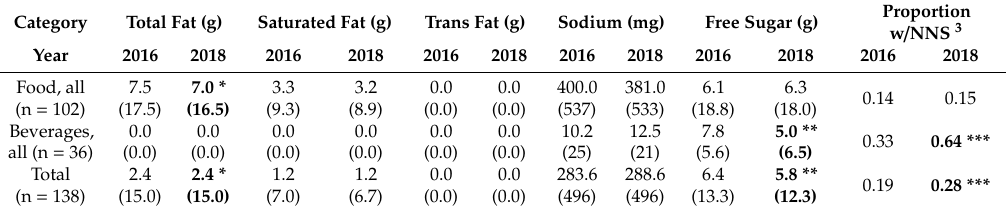
Table A5. Median quantity per 100 g / mL of nutrients of concern by food group in 2016 and 2018 (based on nutrients regulated under the Pan American Health Organization (PAHO) Model)